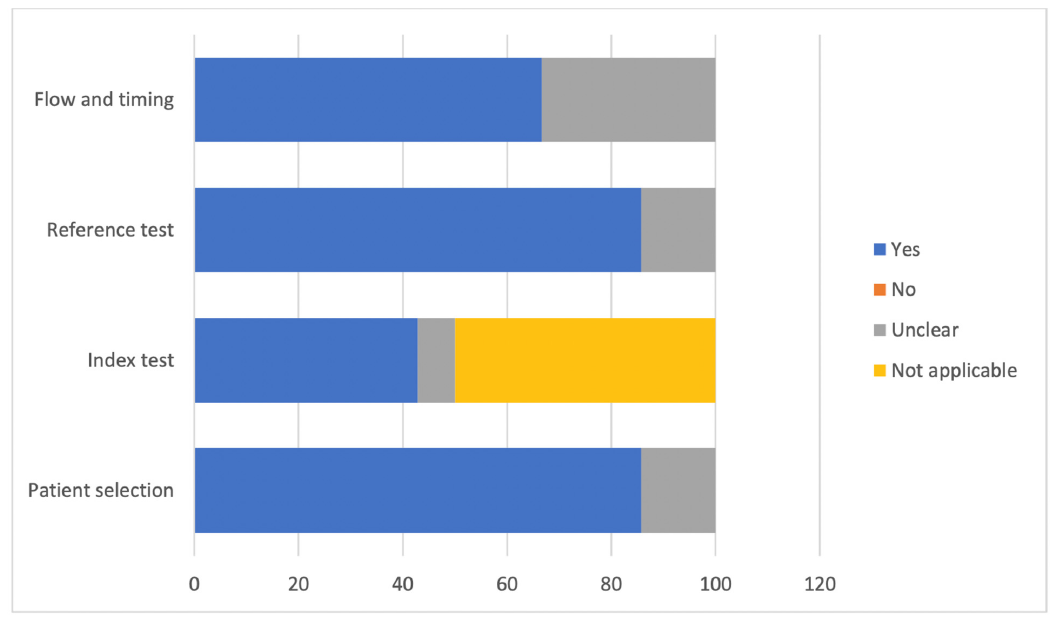
Figure 2. Risk of